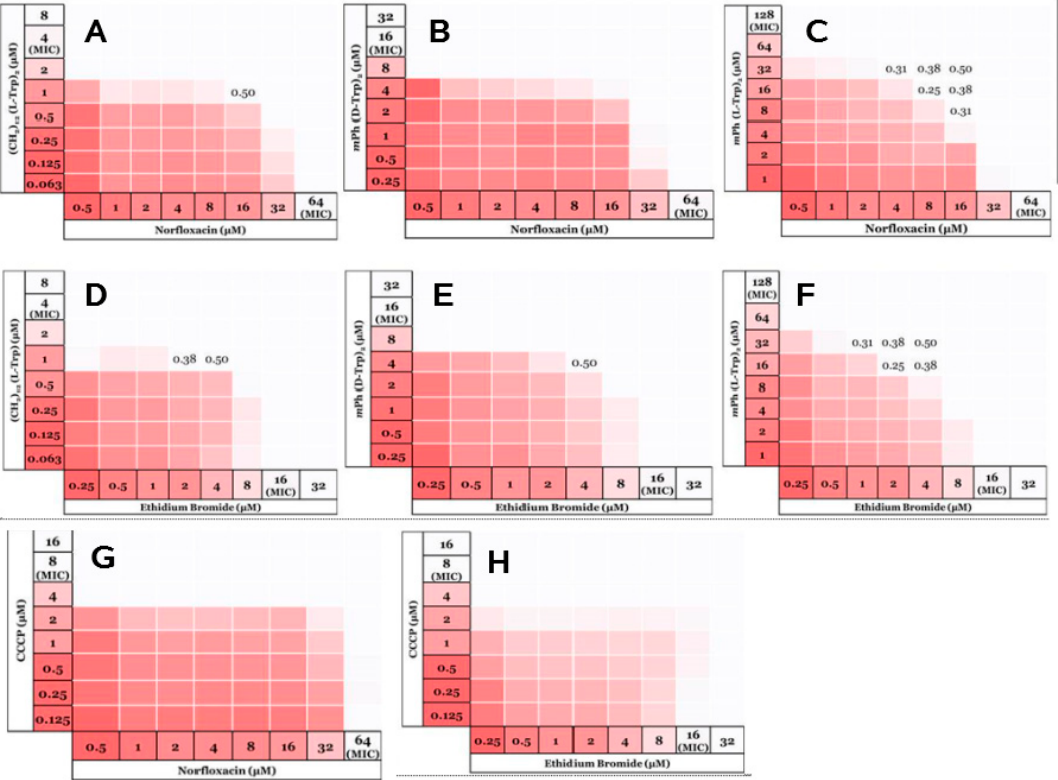
Figure 7. Checkerboard analysis of cooperative function of two different compounds assessed against S. aureus . The y -axis and x -axis compound concentrations ( µ M) respectively are identified for checkerboards A-H as follows. ( A ) W-C 12 -W ( 6 ), norfloxacin; ( B ) w- m C 6 H 4 -w ( 2 ), norfloxacin; ( C ) W- m C 6 H 4 -W, norfloxacin; ( D ) W- n C 12 -W ( 6 ), ethidium bromide; ( E ) w- m C 6 H 4 -w, ethidium bromide; ( F ) W- m C 6 H 4 -W ( 1 ), ethidium bromide; ( G ) CCCP, norfloxacin; ( H ) CCCP, ethidium bromide.